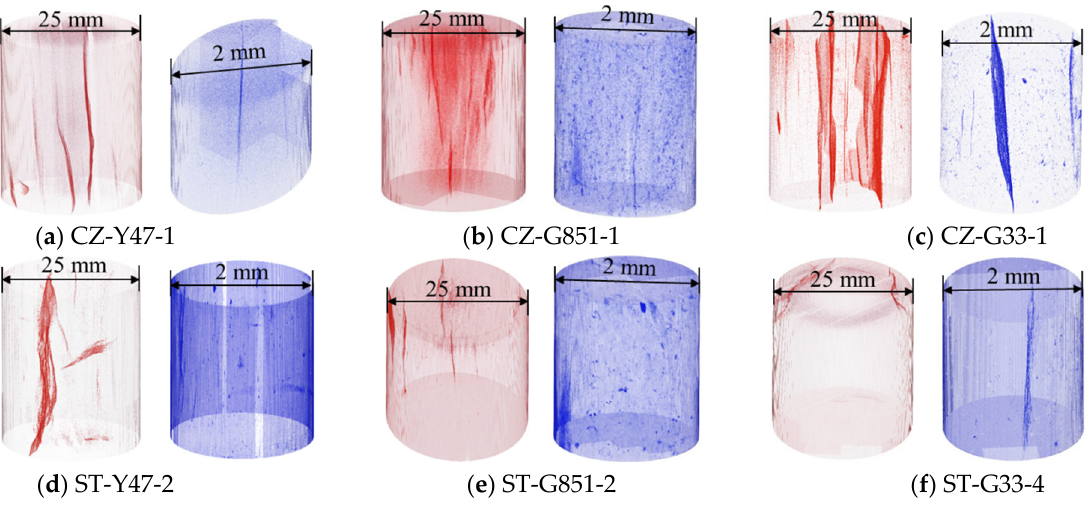
Figure 1. 3D CT reconstruction results of shale cores. Table 2. Characteristic parameters of shale bedding fractures.